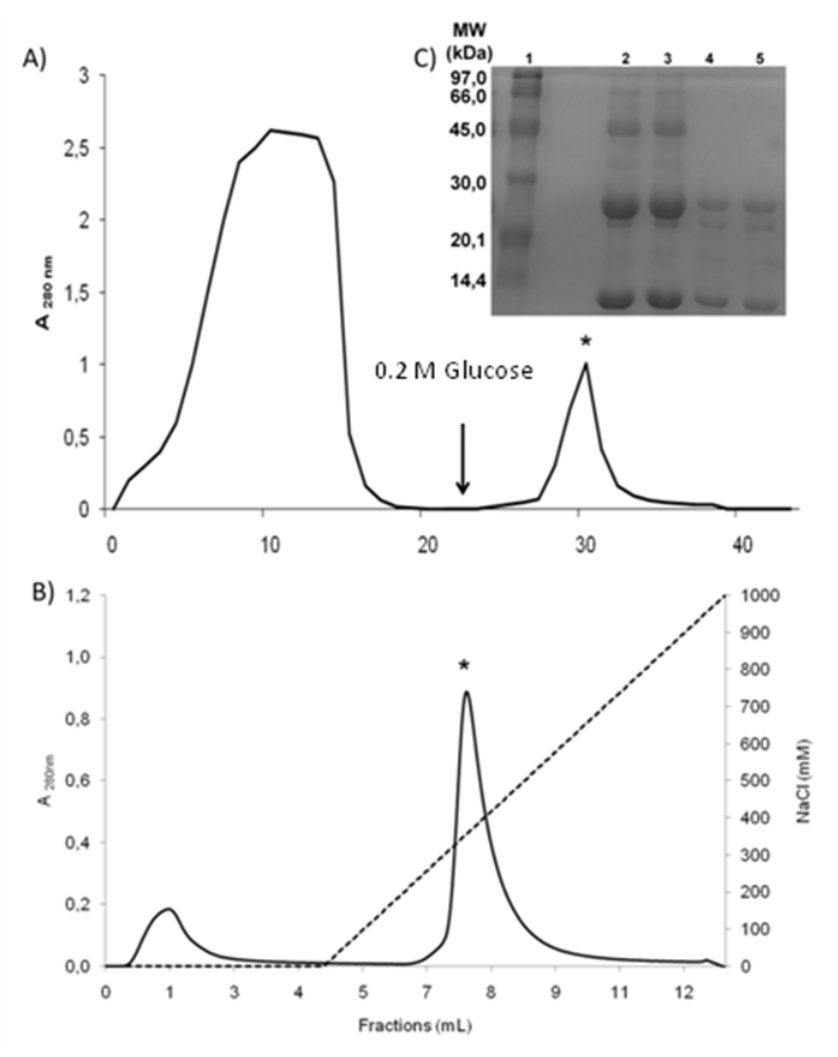
Figure 1. Purification of lectin from the seeds of Dioclea wilsonii (DwL). ( a ) Partial purification of DwL by affinity chromatography on a Sephadex G-50 column. The column was equilibrated and eluted with 0.1 M Tris-HCl buffer (pH 7.4) containing 0.15 M NaCl to remove the unbound proteins. Lectin (*Peak II) was recovered with 0.2 M Glucose or with 0.1 M Glycine buffer (pH 2.6) containing 0.15 M NaCl. ( b ) Purification of DwL by cation exchange chromatography on a SP Sepharose™ XL column using peak II from the affinity chromatography step. The column was equilibrated and eluted by a saline gradient (0–1 M NaCl) to remove contaminants (Peak I). Lectin (*Peak II) was recovered with Acetate buffer (pH 4.5). ( c ) SDS-polyacrylamide gel electrophoresis (15%) of DwL in the presence of β -mercaptoethanol. Lane 1: molecular mass markers [phophorylase b (97 kDa), albumin (66 kDa), ovalbumin (45 kDa), carbonic anhydrase (30 kDa), trypsin inhibitor (20.1 kDa) and α -lactalbumin (14.4 kDa)]. Lanes 2 and 3: Peak II of the Sephadex G-50 column. Lanes 4 and 5: Peak II of the SP Sepharose™ XL